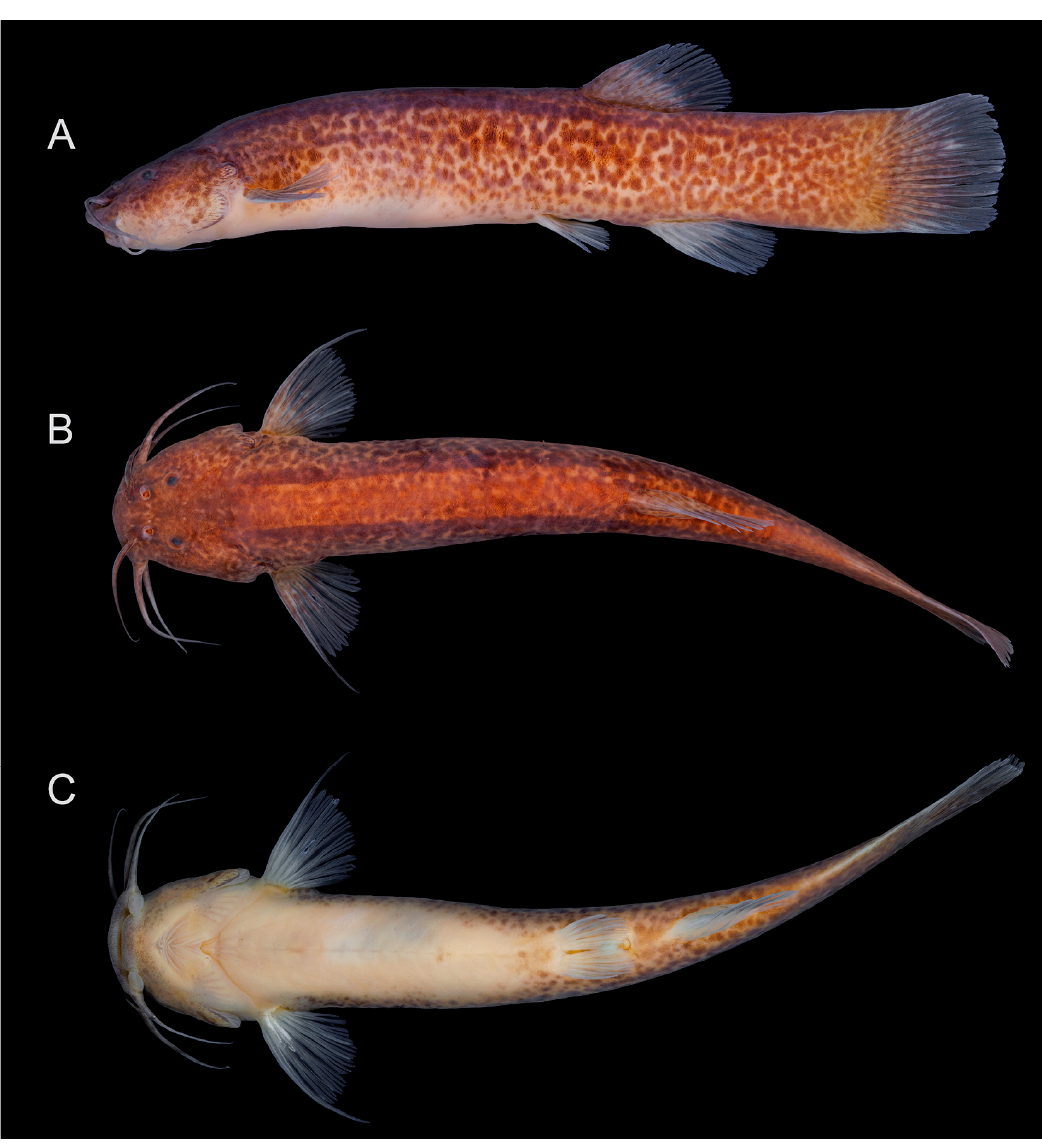
Figure 11. Trichomycterus ( Cryptocambeva ) saturatus Costa, Katz & Azevedo-Santos sp. nov. Holotype, UFRJ 13378, Capitólio, 85.8 mm SL: ( A ) lateral, ( B ) dorsal, and ( C ) ventral views. Diagnosis. Trichomycterus saturatus is distinguished from all other congeners of the subgenus Cryptocambeva by having a goblet-shaped basibranchial 3 as a result of a strong posterior constriction (Figure 10B; vs. subrectangular, Figure 10A). Trichomycterus saturatus is distinguished from other species of Cryptocambeva , except for T. claudiae , T. mirissumba , T. mariamole , T. pirabitira , and T. vermiculatus , by a combination of an anterior segment